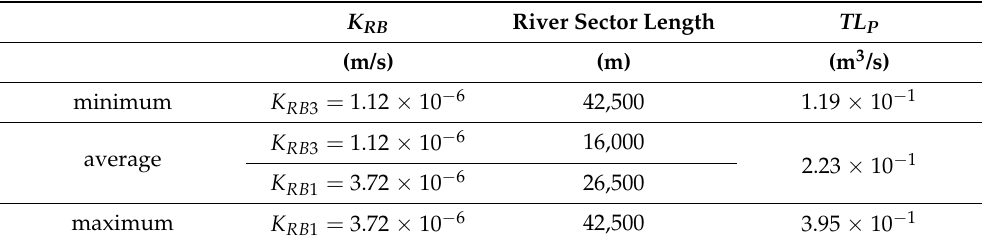
Table 3. Estimated minimum, average and maximum values of the potential transmission losses ( TL ) along the Canale Reale River. P